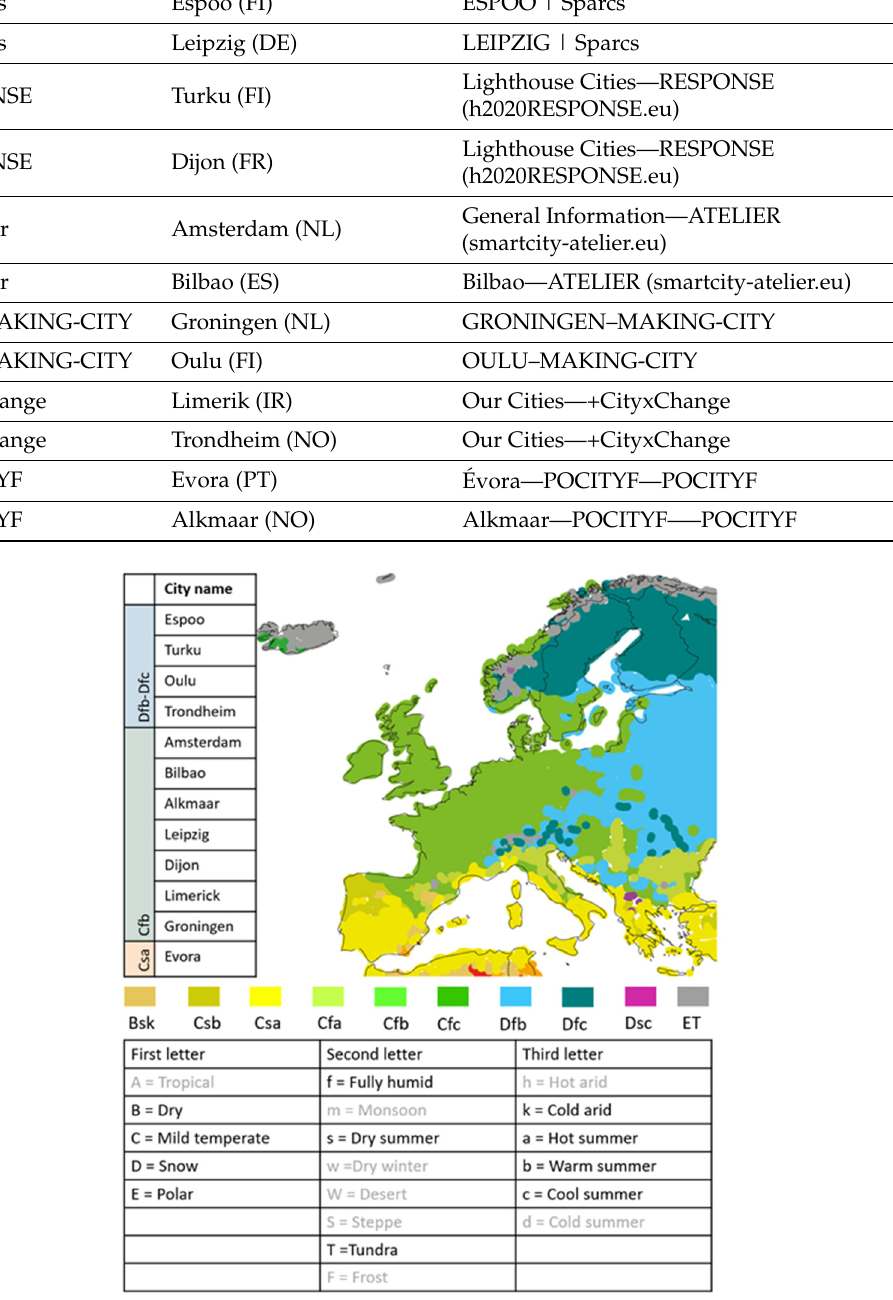
Figure 6. Köppen climate classification map and the class of the examined cities [105–107].